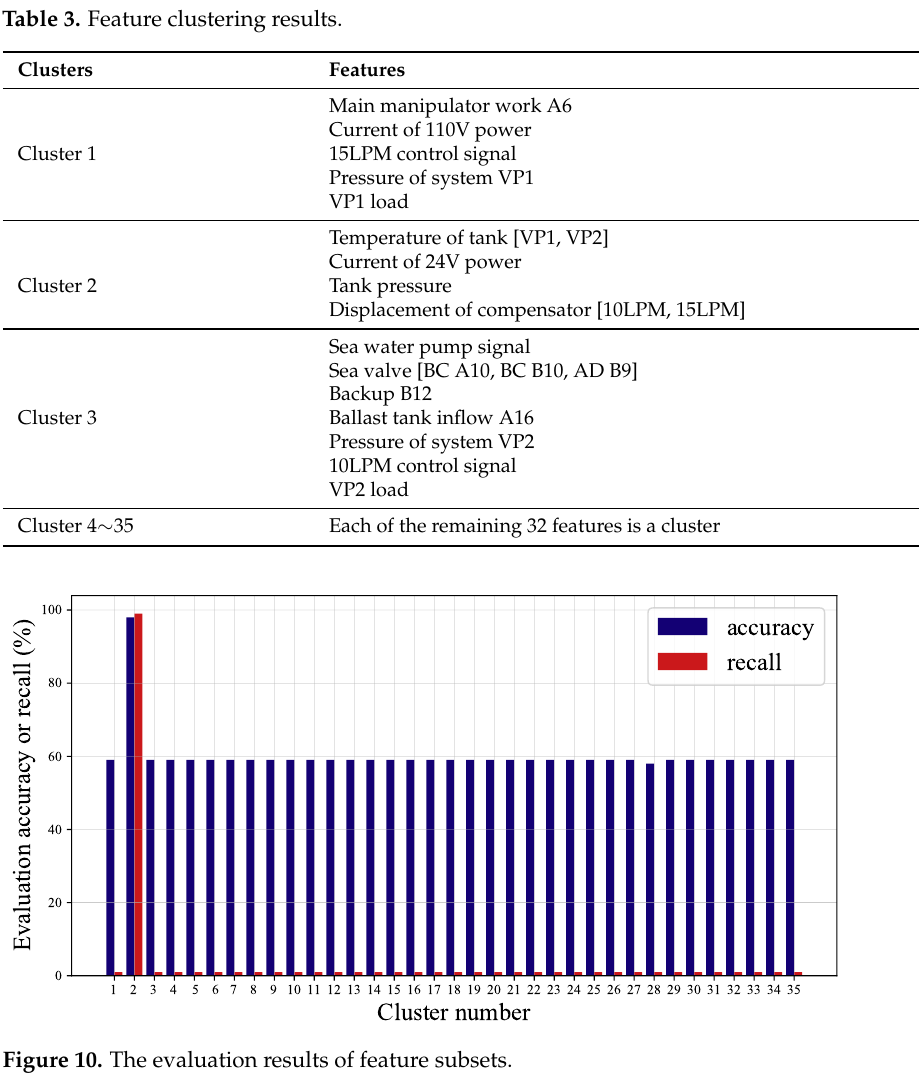
Figure 10. The evaluation results of feature